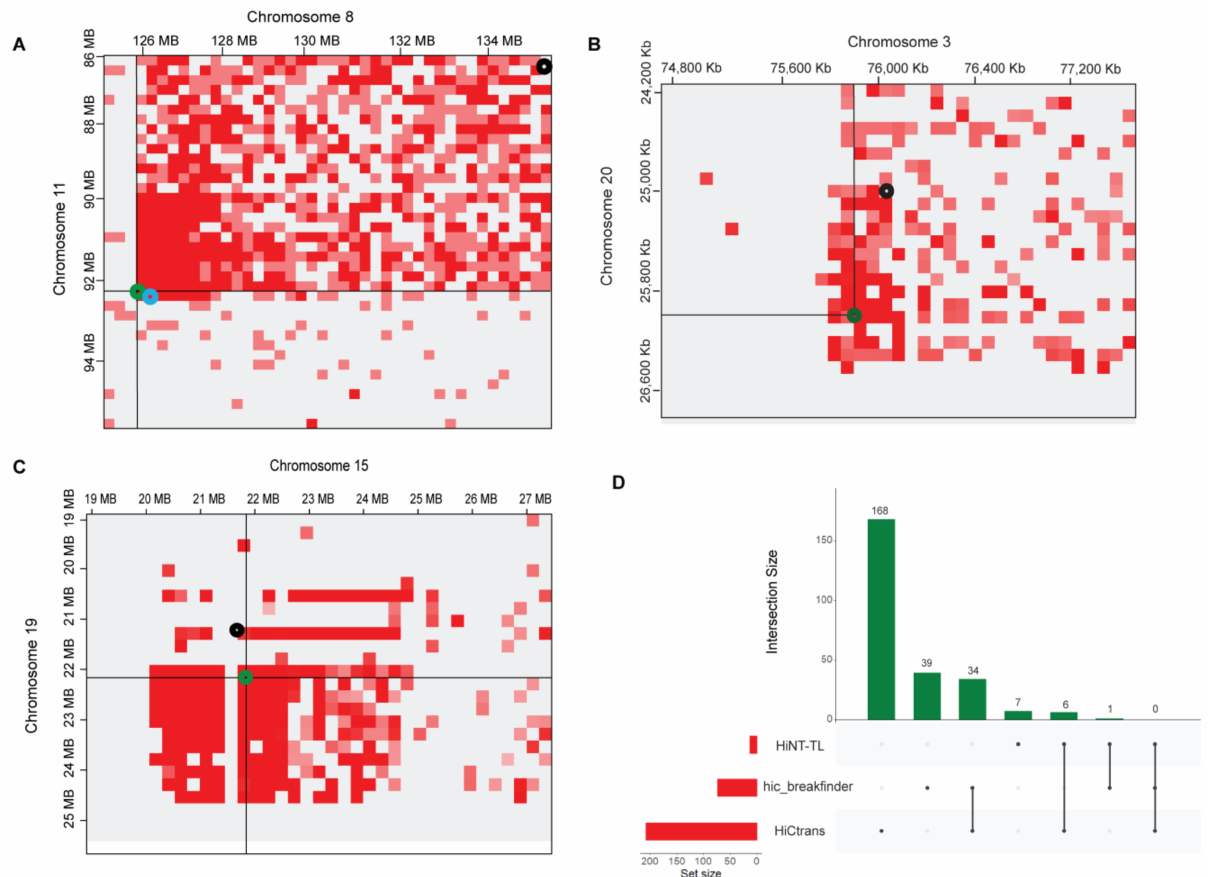
Figure 4. Translocations identified in A549 cell line in magnified representation of translocated regions detected by Hi-C-based tools. ( A ) breakpoints between chromosome 8 and chromosome 11, ( B ) breakpoints between chromosome 3 and chromosome 20, and ( C ) breakpoints between chro- mosome 15 and chromosome 19. Green circle; HiC_trans, Black circle; hic_breakfinder and Cyan circle HiNT-TL. ( D ) UpSet plot is showing the breakpoints results of translocations detected by different methods. Black dots indicating sample set, and vertical black line is showing the intersection between